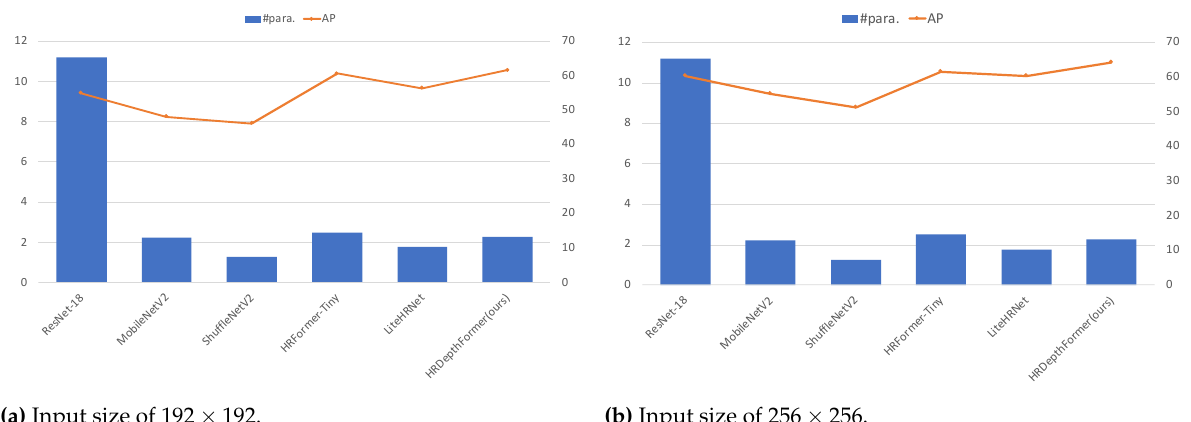
Figure 5. Demonstration of the AP and parameters of the lightweight networks on the AP-10K test set with inputs of different sizes.